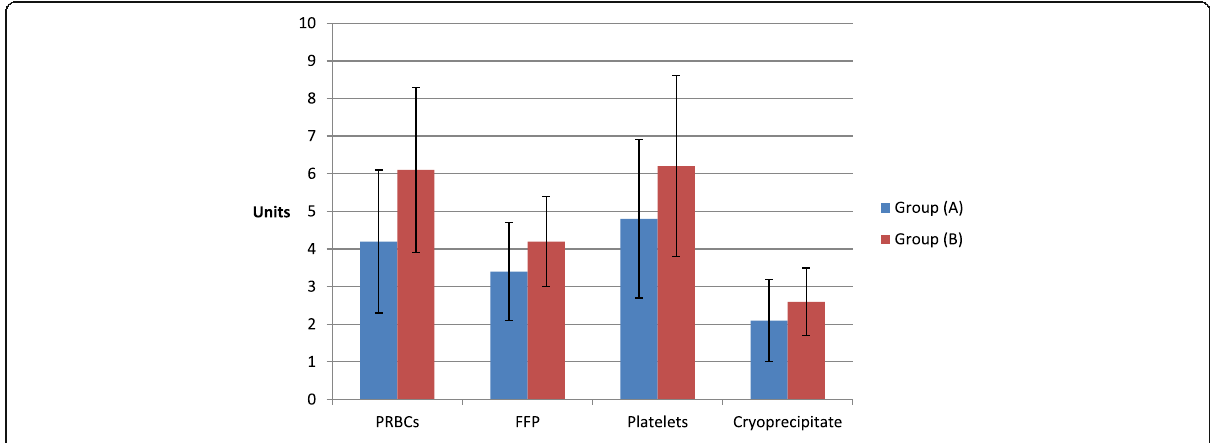
Fig. 2 The intraoperative amount of blood and products transfusion